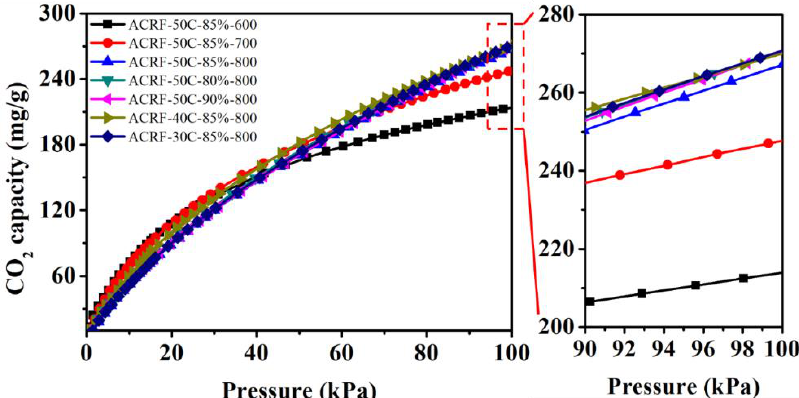
Figure 6. CO 2 capacities of ACRFs at 273 K. Table 1. Specific surface areas, pore volume and CO 2 capacities of ACRFs.